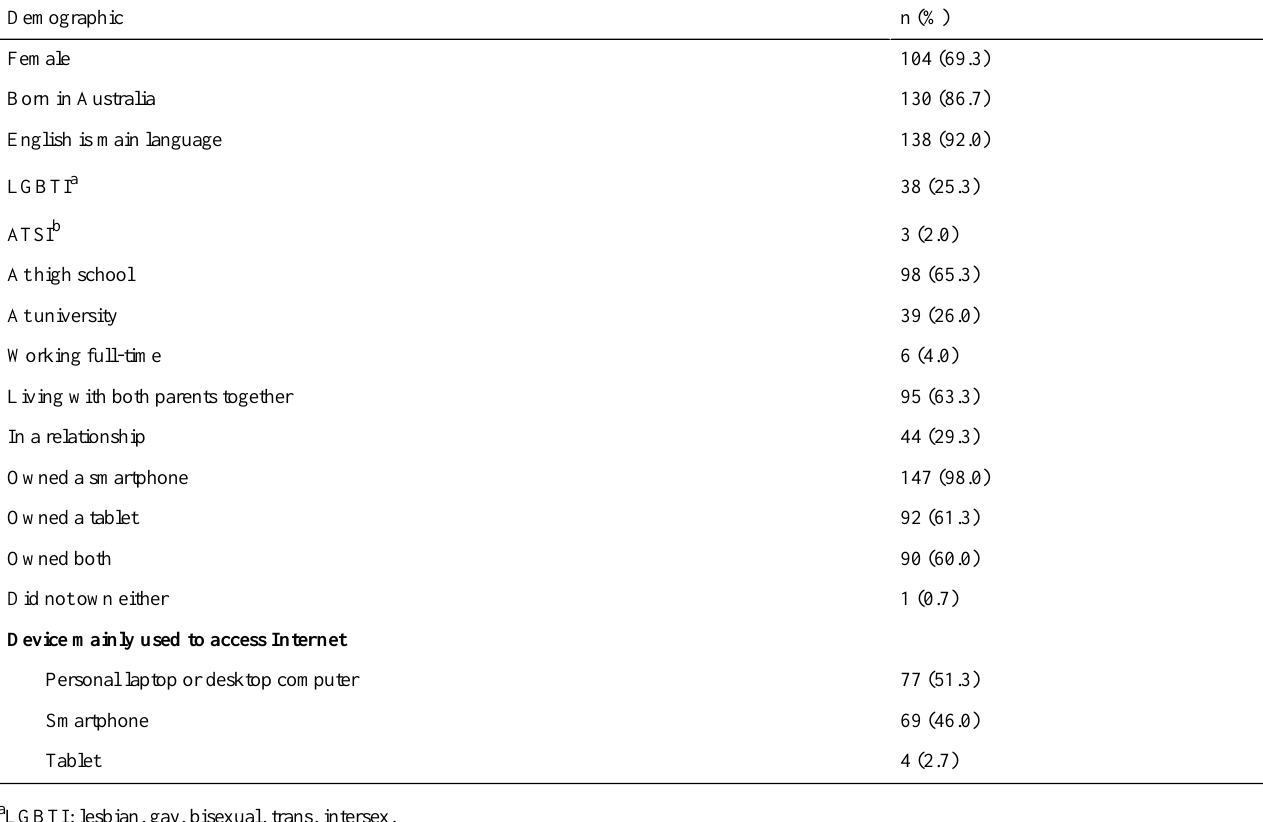
Table 2. Participant characteristics (N=150).